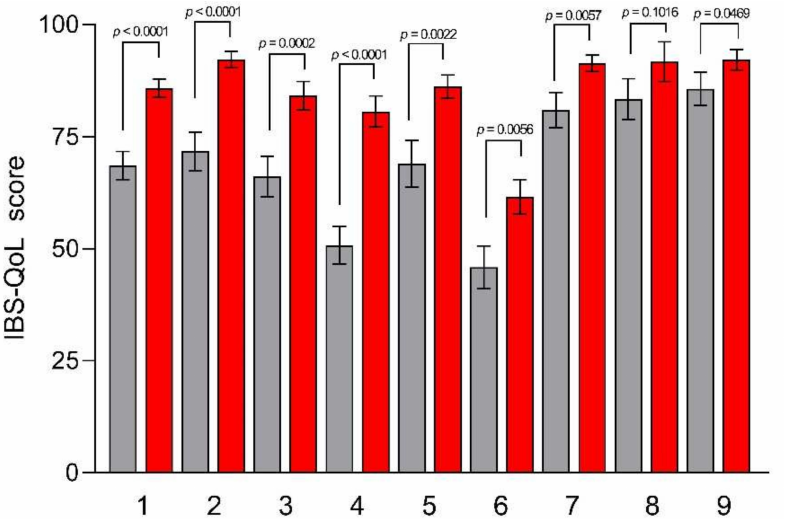
Figure 2. IBS-QoL subscale scores before and after the Tritordeum-based diet. Data are expressed as means ± SEM and analyzed by the Wilcoxon matched-pairs signed rank test. All differences were considered significant at p < 0.05. Subscales: ( 1 ) total score; ( 2 ) dysphoria; ( 3 ) interference with activity; ( 4 ) body image; ( 5 ) health worry; ( 6 ) food avoidance; ( 7 ) social reaction; ( 8 ) sexual concerns; and ( 9 ) relationship. Grey columns (Pre-diet), red columns (Post-diet).